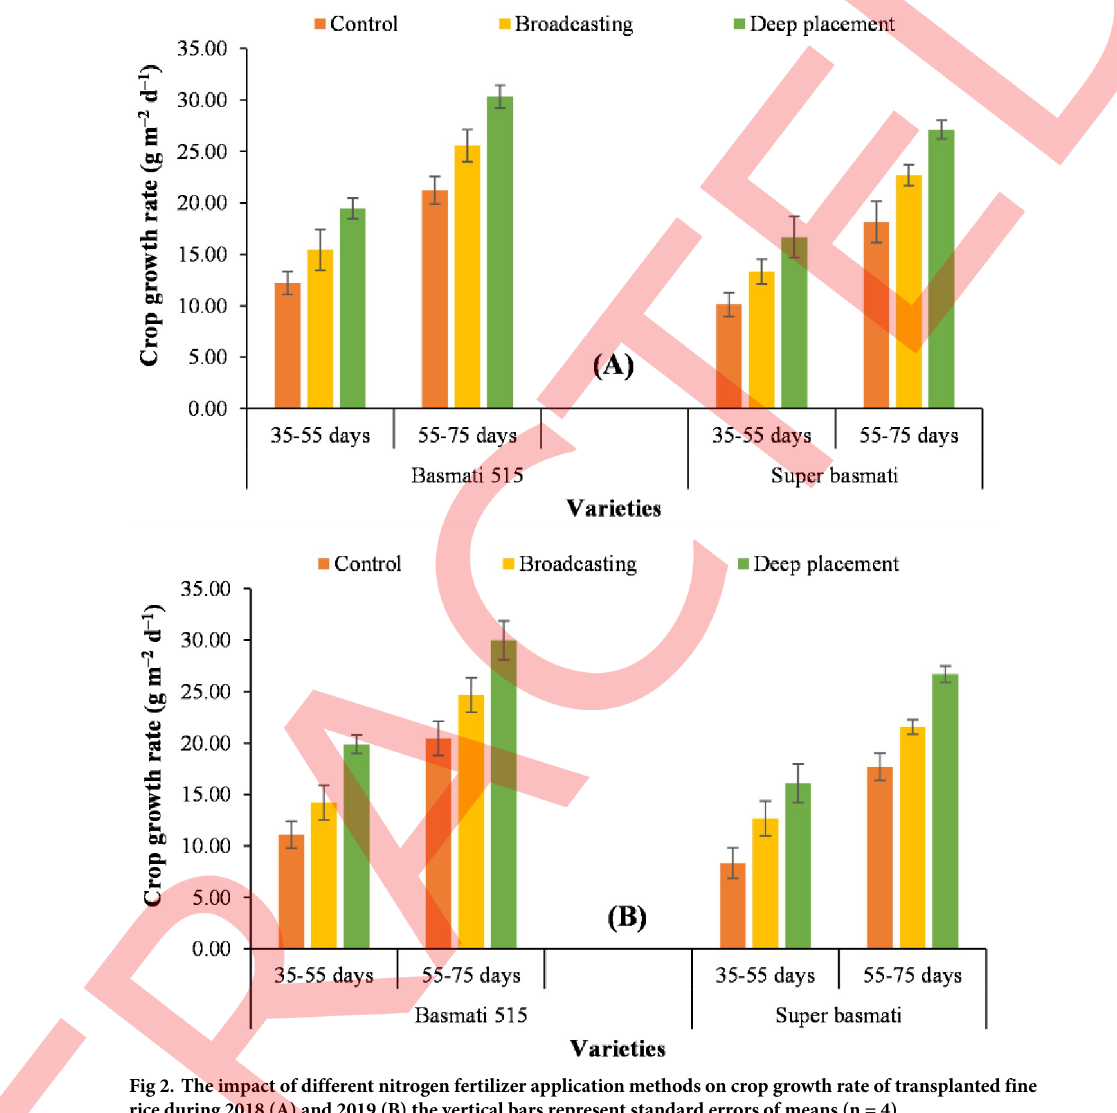
Fig 2. The impact of different nitrogen fertilizer application methods on crop growth rate of transplanted fine rice during 2018 (A) and 2019 (B) the vertical bars represent standard errors of means (n = 4).